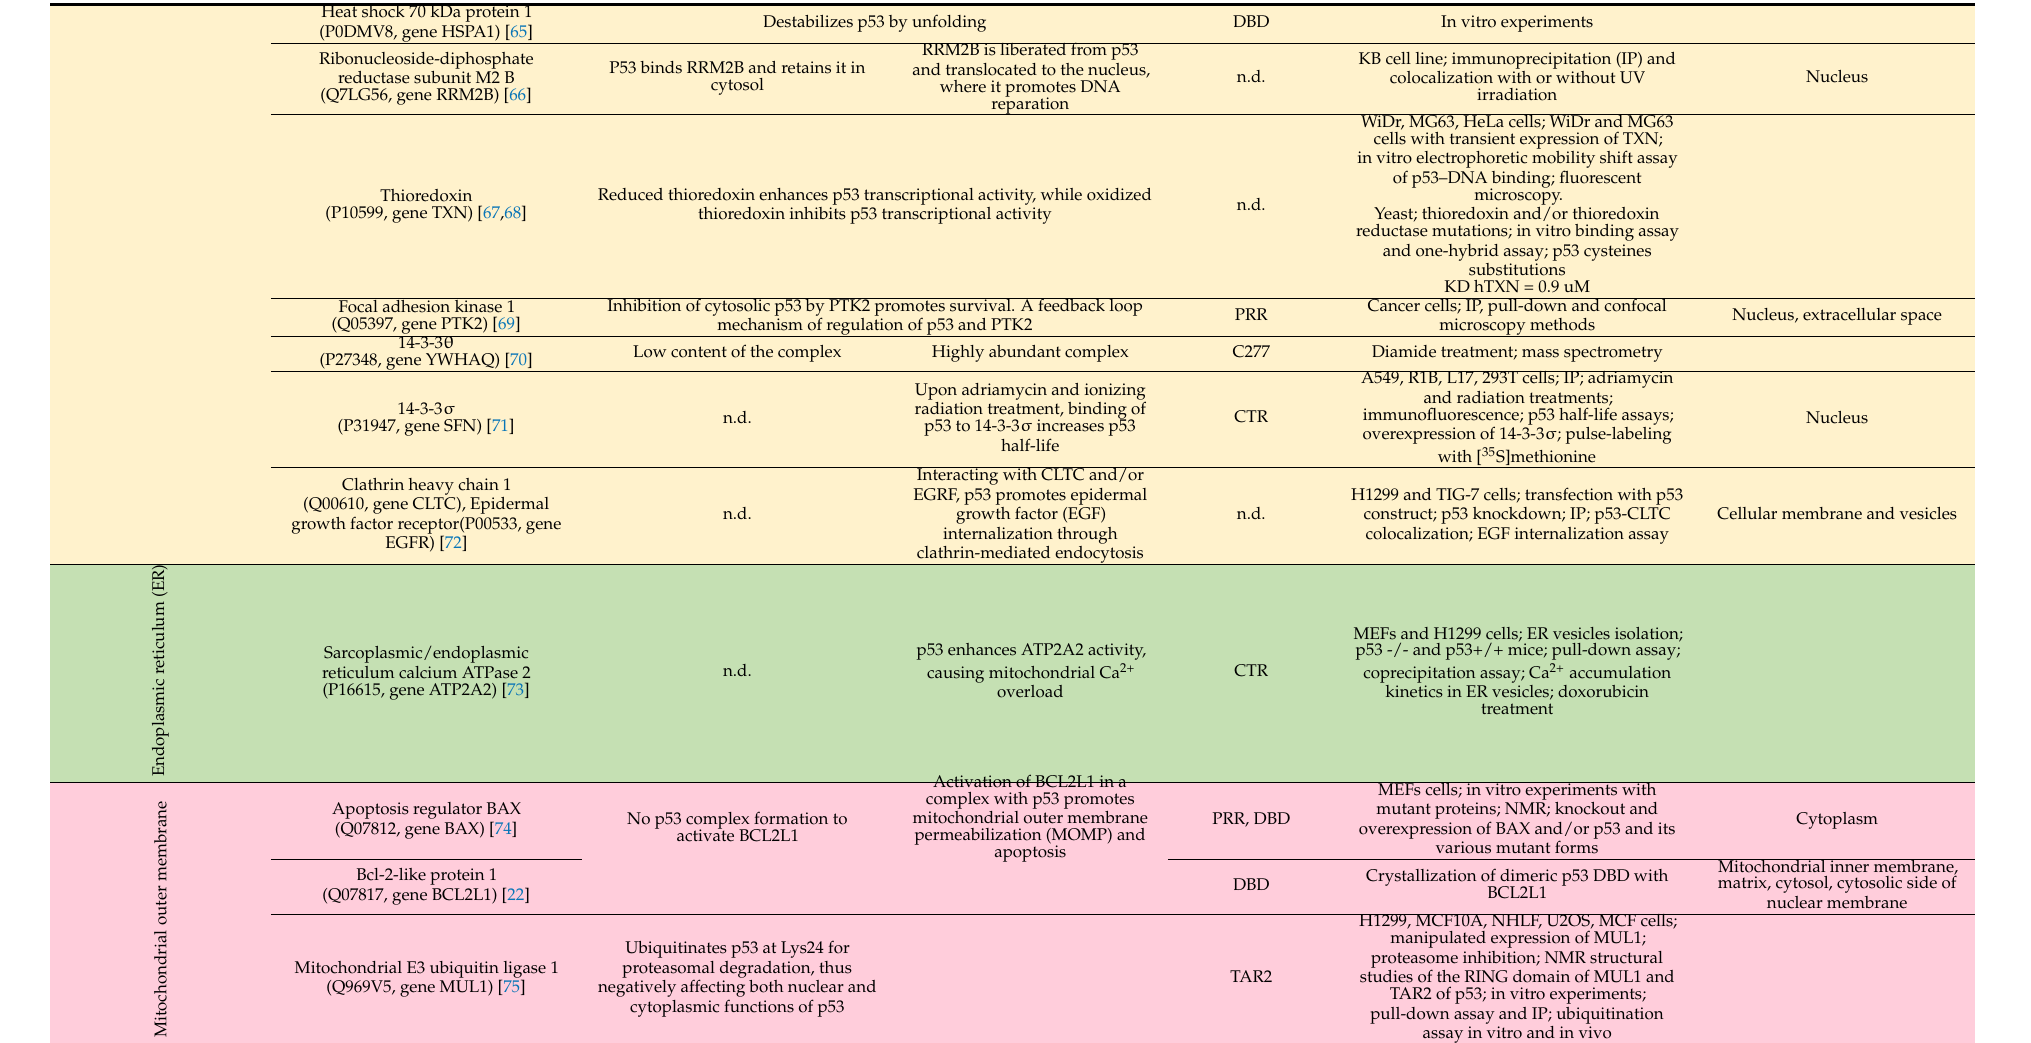
Table 1. Cont. Heat shock 70 kDa protein 1 (P0DMV8, gene HSPA1) [65] Destabilizes p53 by unfolding DBD In vitro experiments Ribonucleoside-diphosphate reductase subunit M2 B (Q7LG56, gene RRM2B) [66] where it promotes DNA reparation